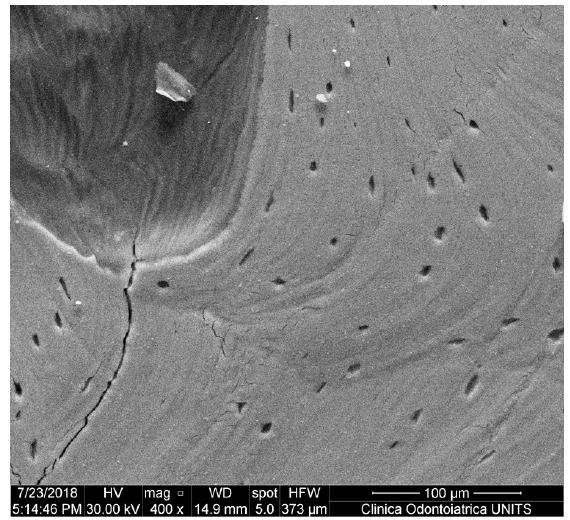
Figure 6. Secondary electrons SEM image of the interface between NFB (upper-right), RG (lower), and MS (upper-left). SEM, scanning electron microscope; NFB, newly-formed bone; RG, residual graft; MS, marrow spaces.